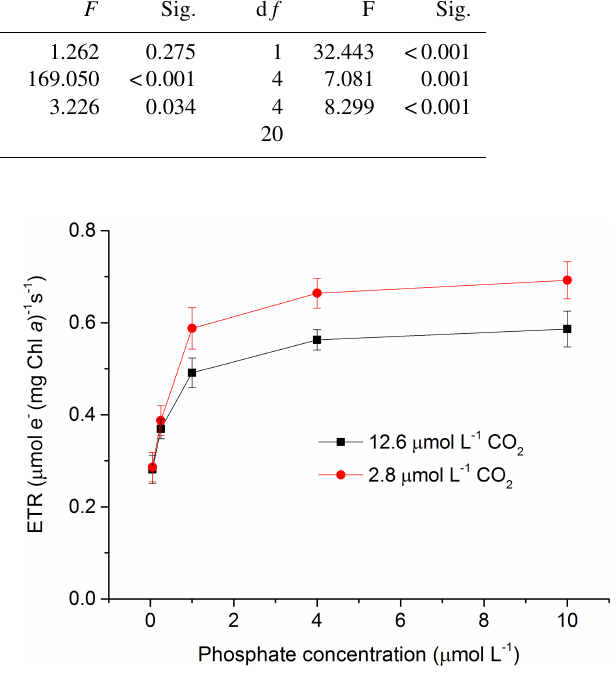
Figure 2. Relative electron transport rate (rETR) in S. costa- tum grown at various phosphate concentrations after 12.6 and 2.8µmol CO 2 treatments. The error bars indicate the standard devi- ations ( n =